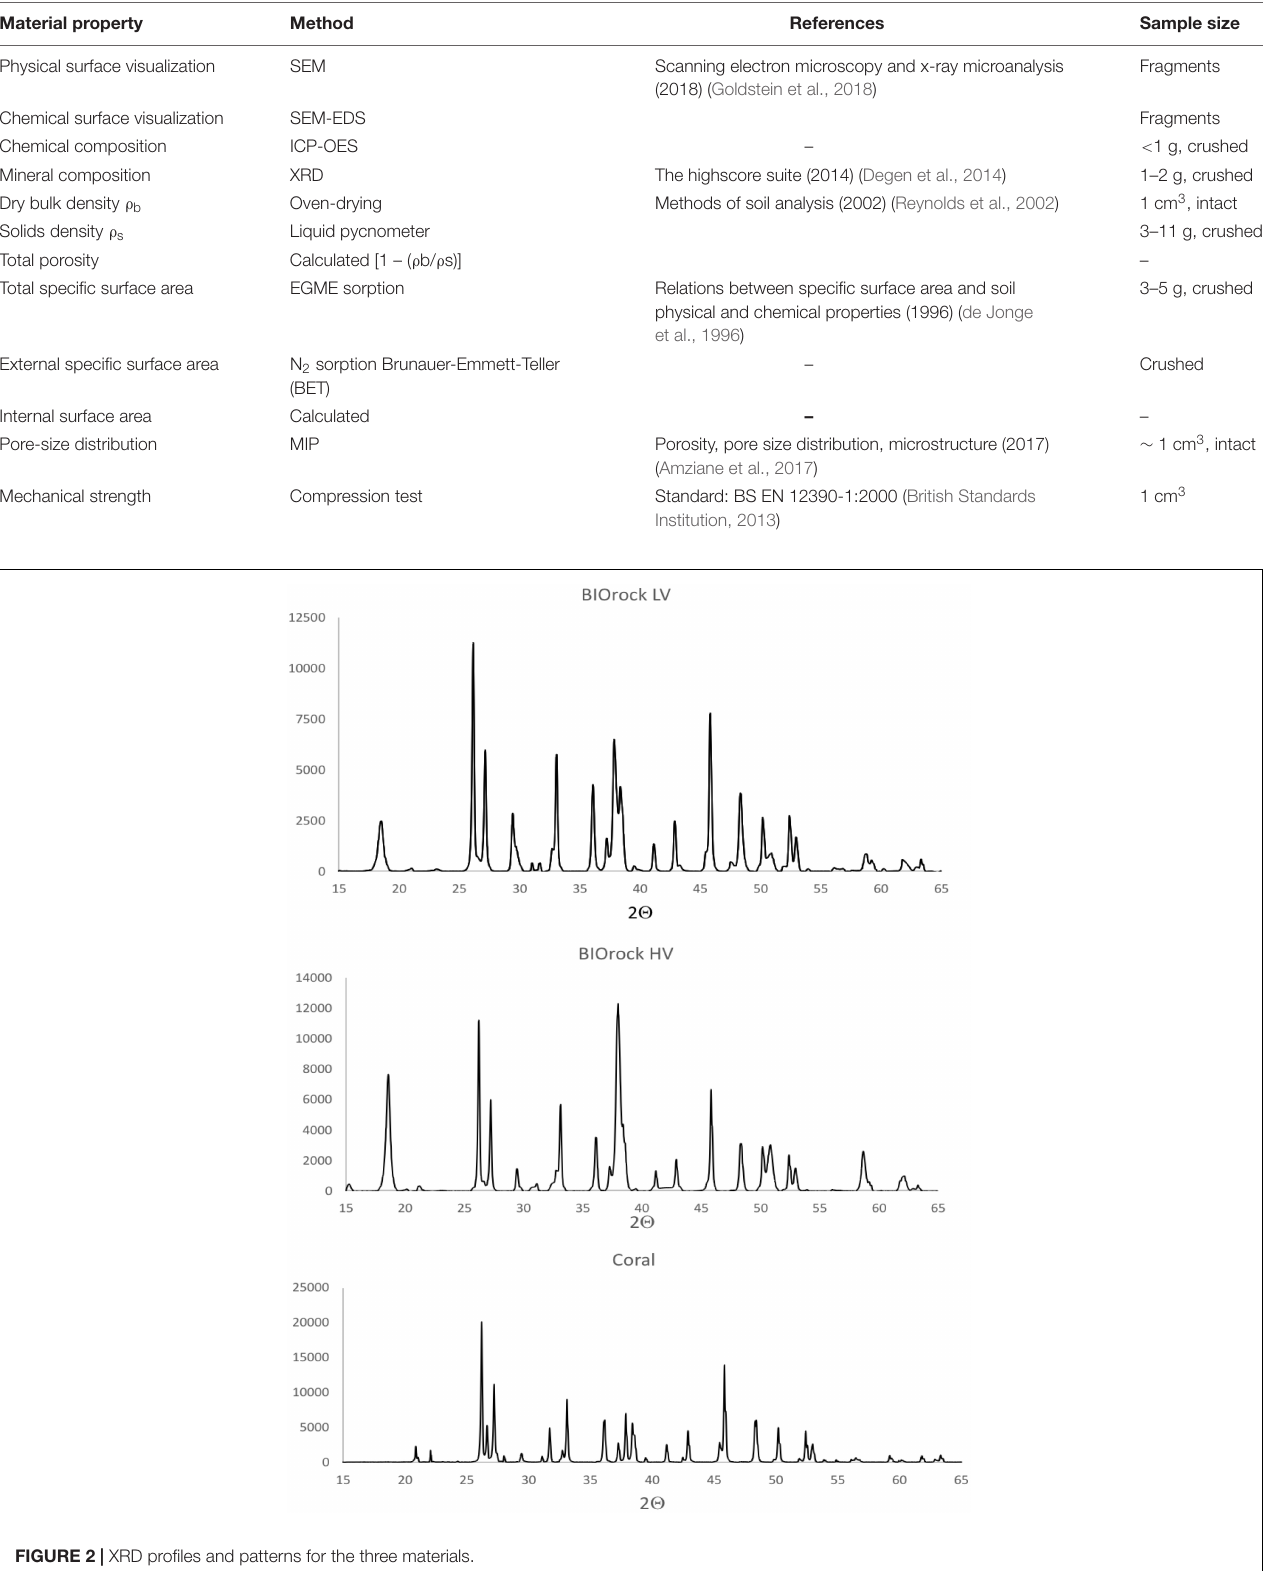
TABLE 3 | Methods used for the characterization of CPE, LVMD, and HVMD.